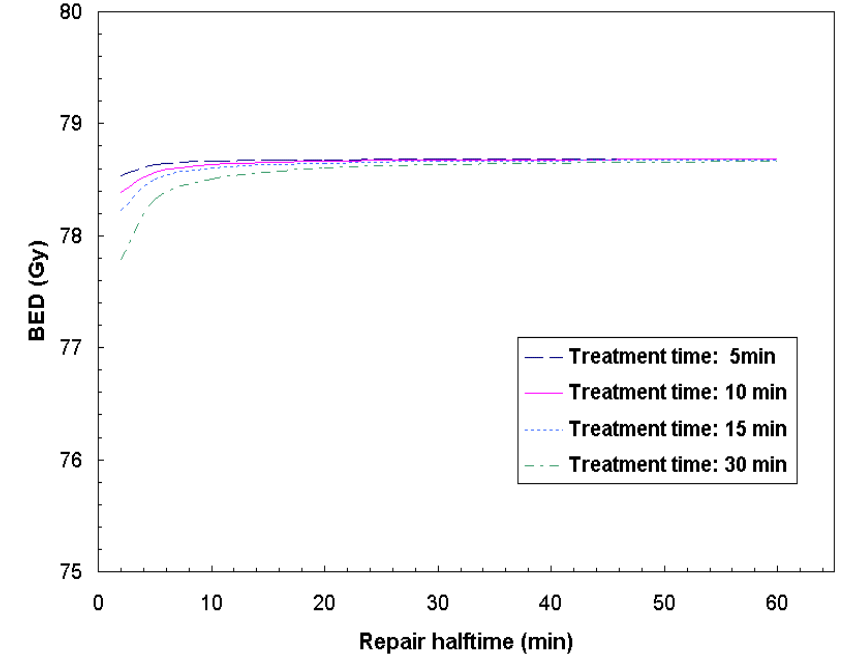
Figure 2. The calculated BED and TCP as a function of repair halftime for H&N tumor. The combined parameter based on the studies of two cell lines from this analysis: α / β = 8.3 ± 4.1 Gy, α = 0.22 ± 0.08 Gy − 1 and repair halftime T T = 4.0 ± 1.8 days were used in the calculation. The fraction dose delivery time of 2, 10, d 17 and 30 min were calculated and